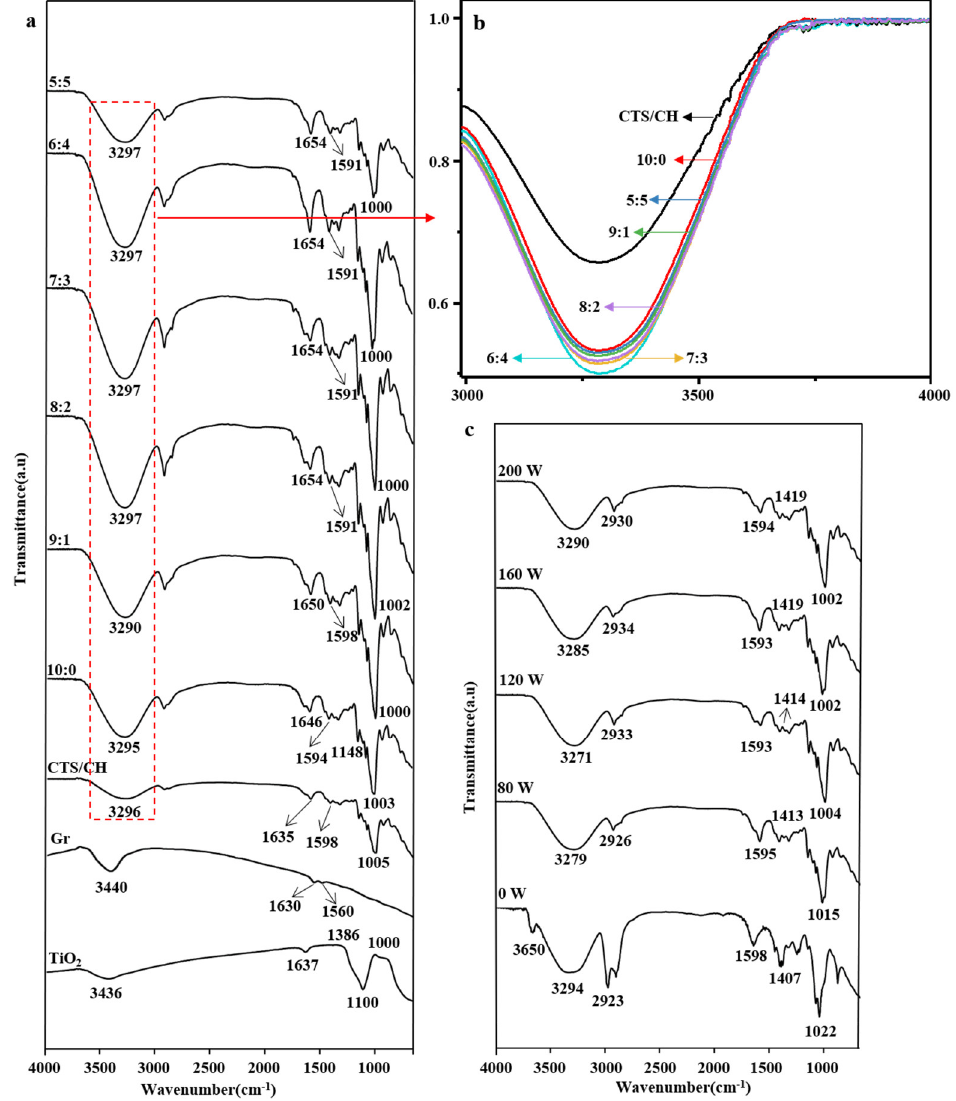
Figure 2. ( a ) FTIR spectra of the CTS/CSH, CTS/CSH/TiO 2 , and CTS/CSH/TiO 2 /Gr composite films; ( b ) Graph normalized to the hydroxyl peak intensity; ( c ) Typical CTS/CSH/TiO 2 /Gr composite film (TiO 2 :Gr = 6:4) fabricated at various ultrasonication powers.